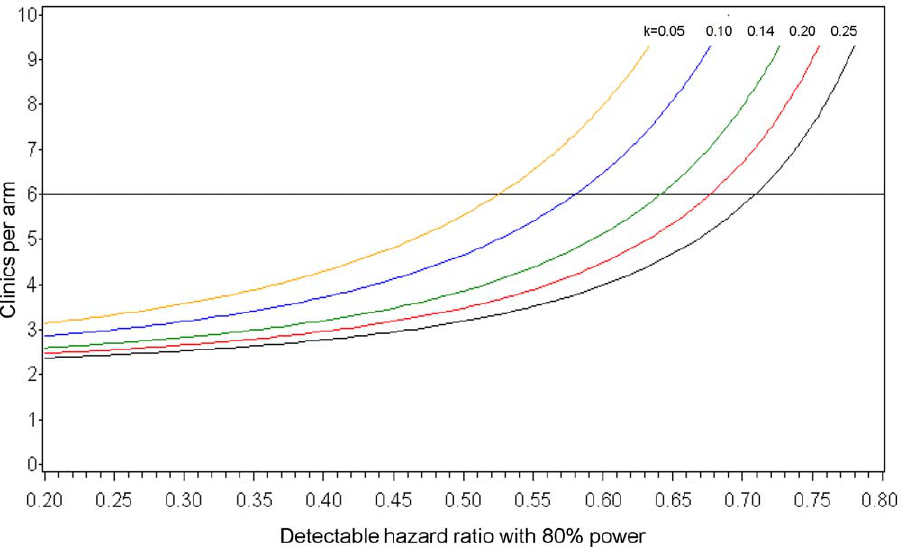
Figure 2. Detectable hazard ratio as a consequence of utilizing routine HIV-1 viral load monitoring at varying between-clinic coefficients of variation. Calculation assumes a historical 18 month post-ART mortality rate of 15.6 per 100 years (140 patients remaining per clinic).